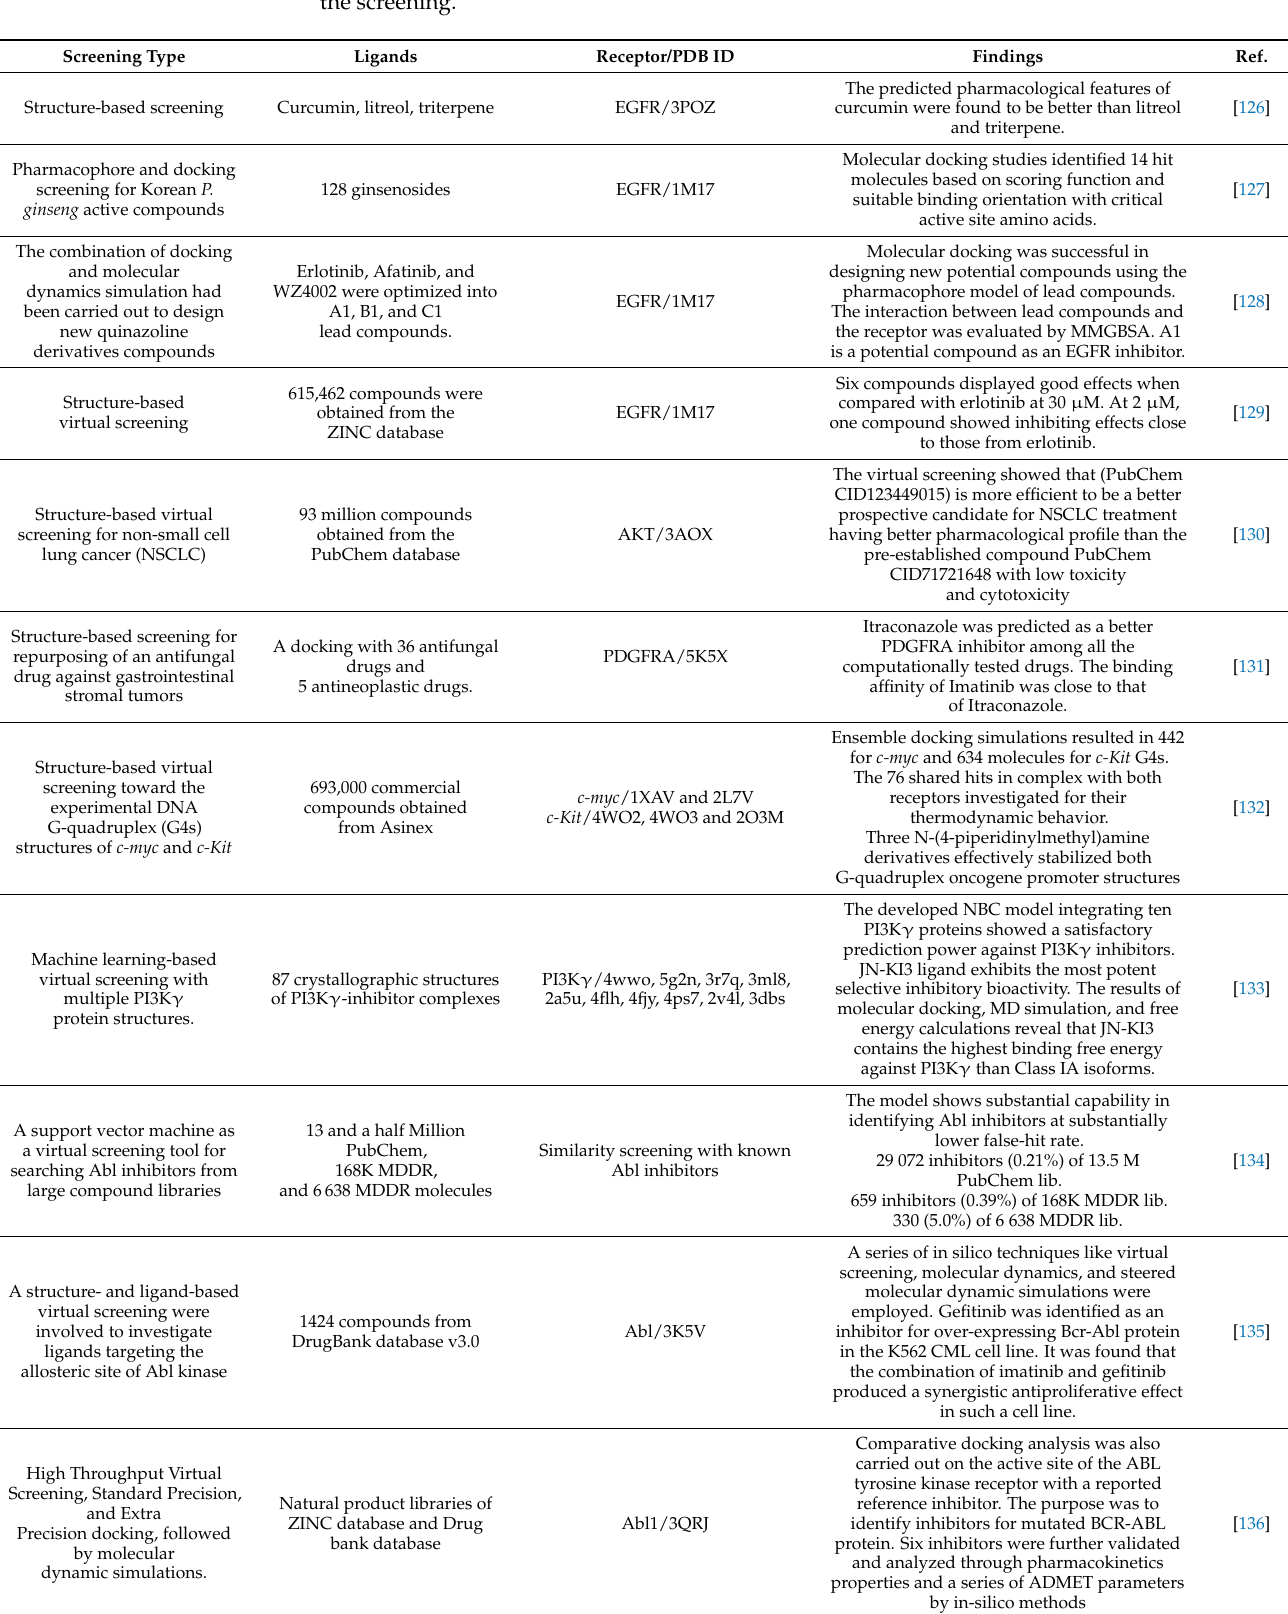
Table 4. The characteristics of virtual screening, protein kinases, and the resulting compounds of the